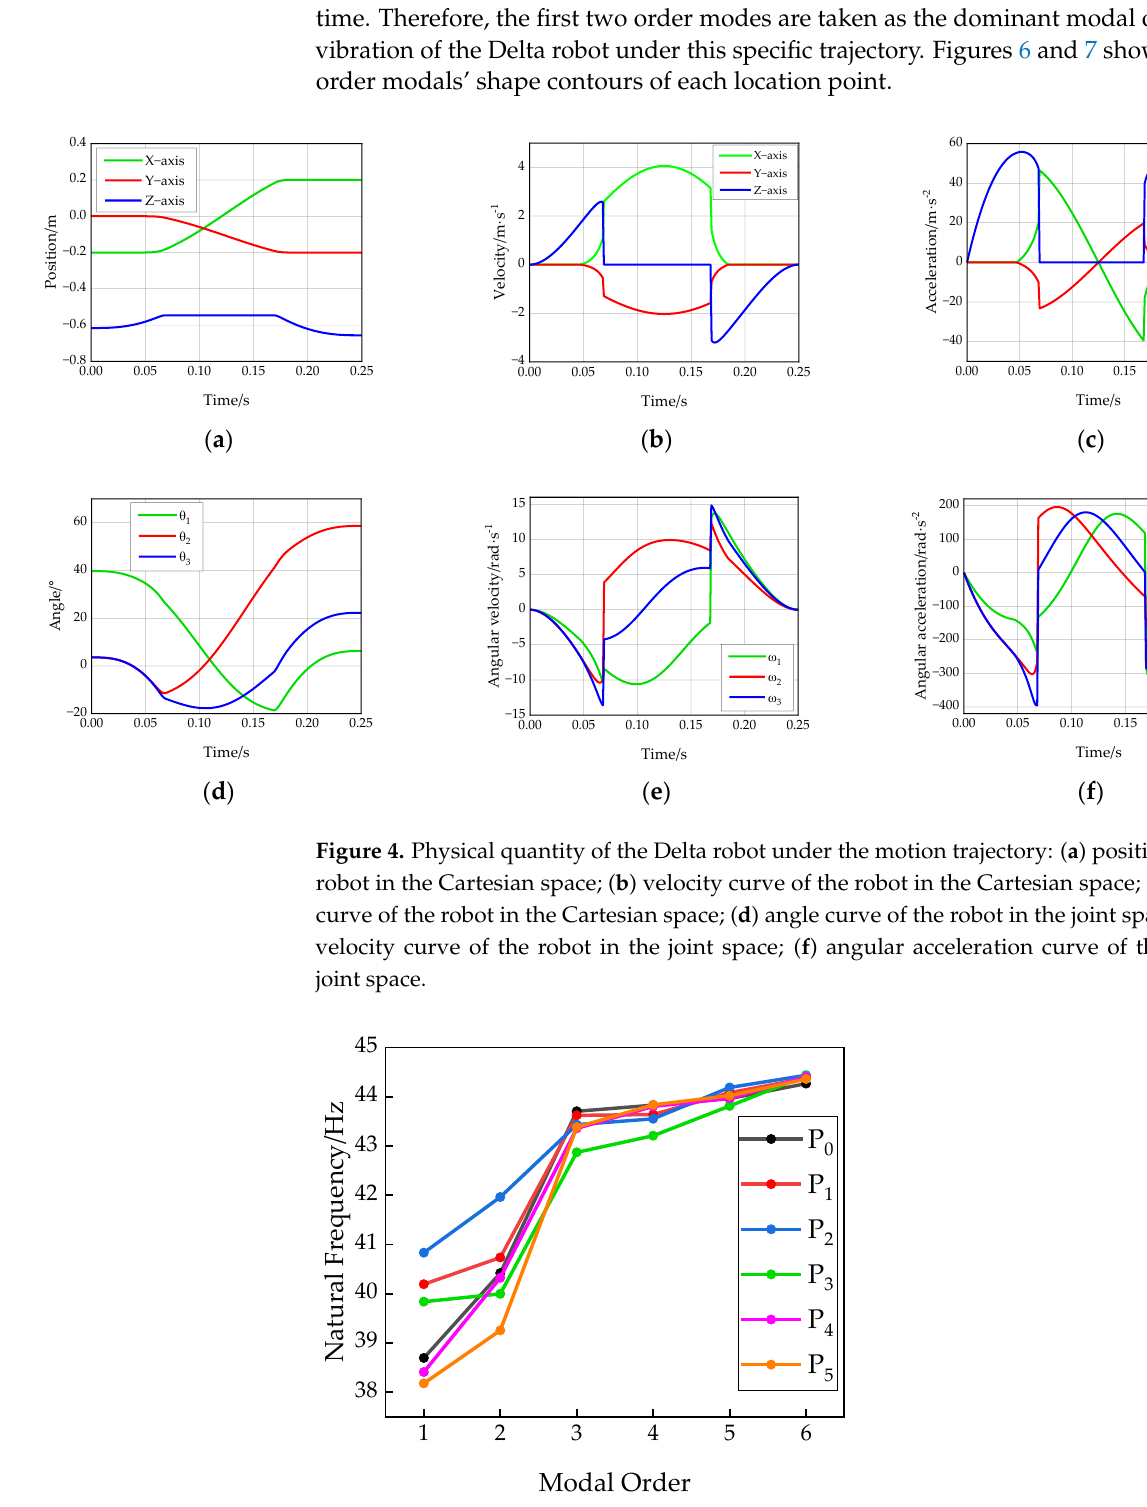
Figure 5. First six modals of each position point. Table 4. Description of point vibration shapes of the robot at each position.